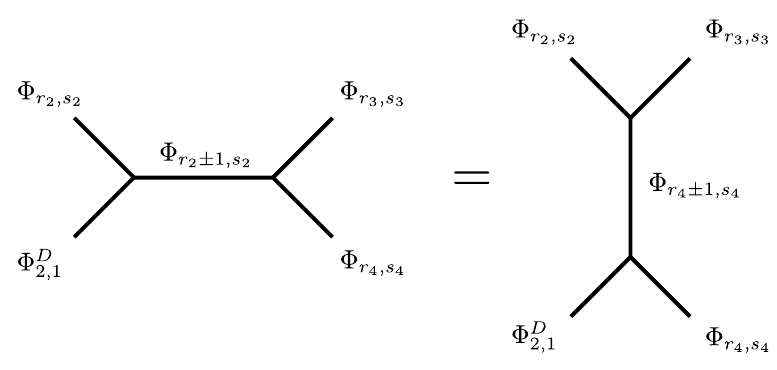
Φ r Φ r Φ r i 2 , 1 2 ,s 2 3 ,s 3 4 ,s 4